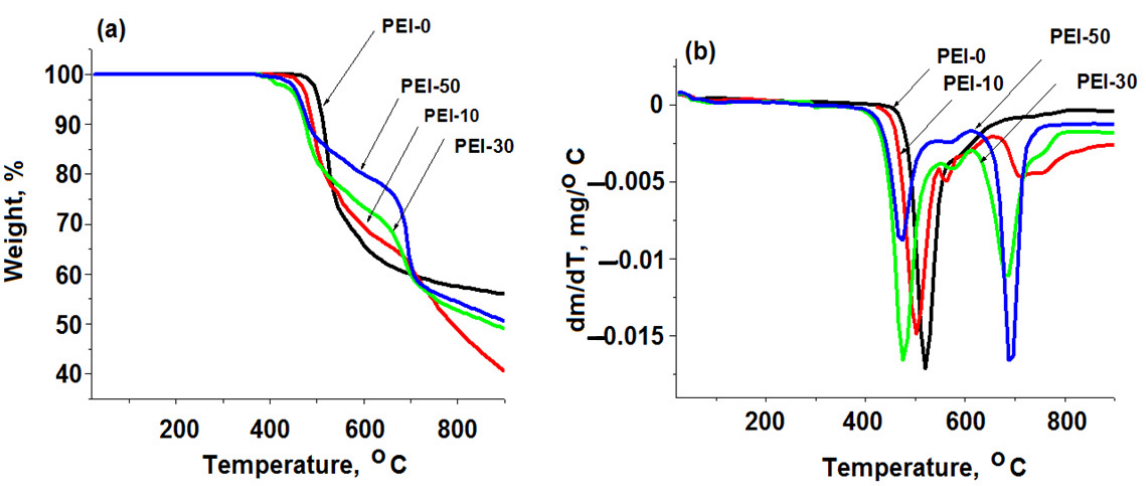
Figure 2. TG ( a ) and DTG ( b ) curves of the PEI-0, PEI-10, PEI-30, and PEI-50. Table 1. The main thermal characteristics of the PEI-0, PEI-10, PEI-30, and PEI-50. Sample Stage